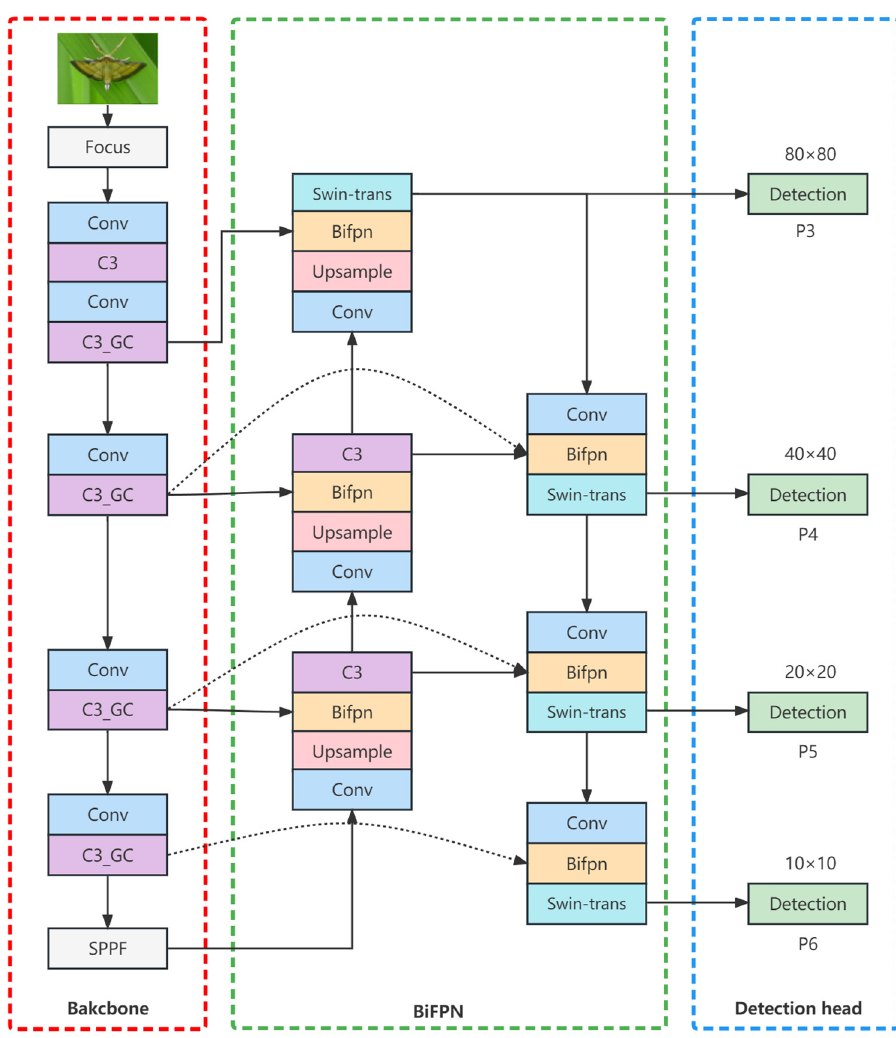
Figure 3. Structure diagram of YOLO-GBS.